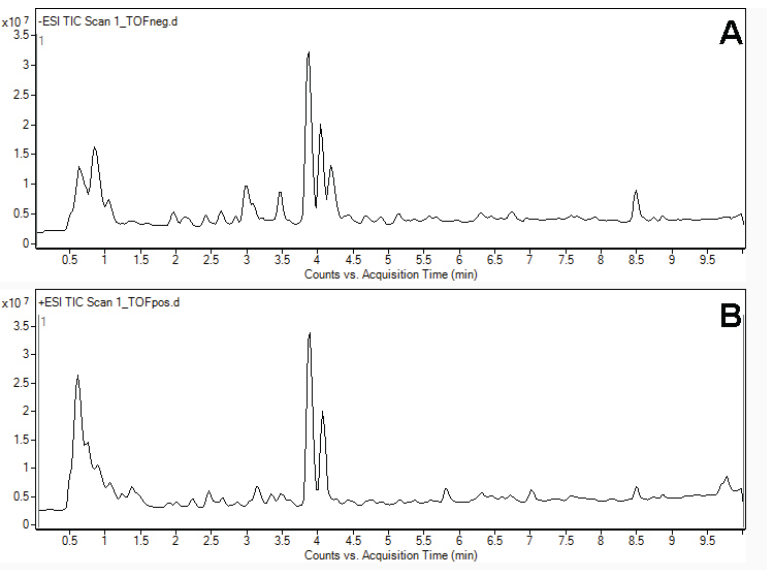
Figure 1: UHPLC-Q-TOF total ion chromatograms obtained for urine sample in TOF mode for negative (A) and positive (B)